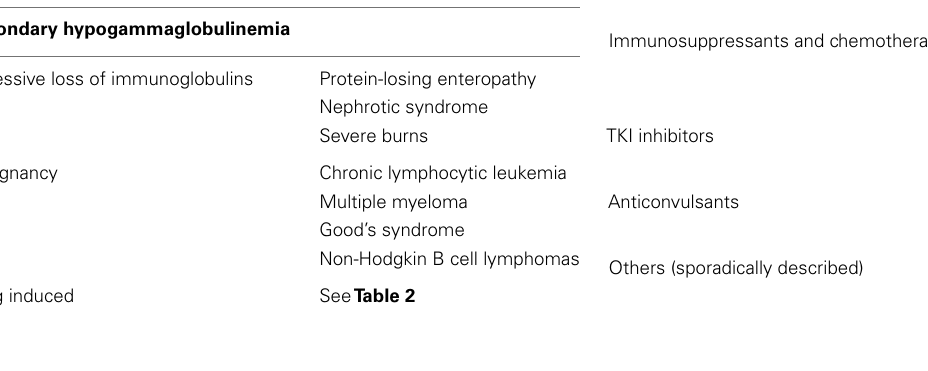
Table 1 | Main causes of secondary hypogammaglobulinemia .